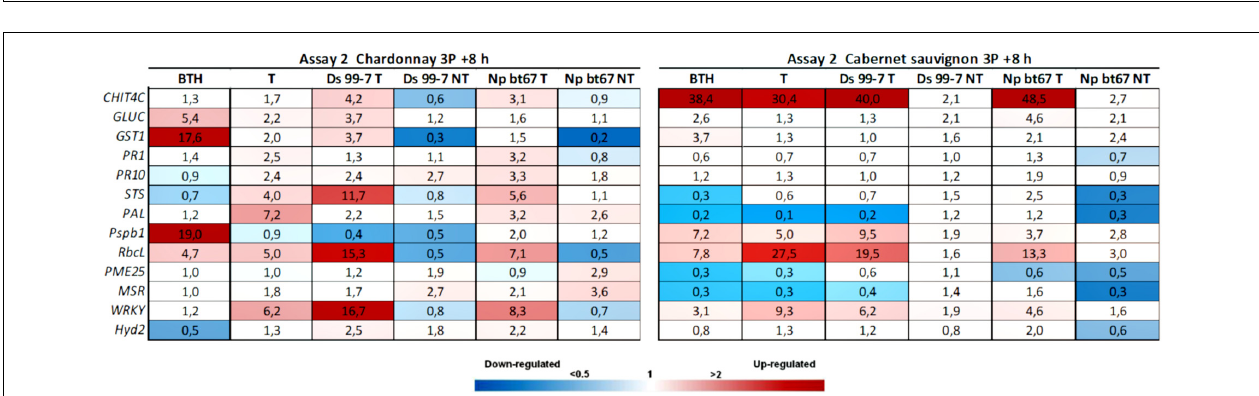
FIGURE 3 | Expression levels of the selected 13 genes recorded by RT-qPCR in “Chardonnay” and “Cabernet sauvignon” 8 h after the second LC2017 treatment (2B) in Assay 2. Values (mean of three technical replicates) represent the expression levels ( (cid:49)(cid:49) Ct) of reported conditions relatively to the control (NT). Expression of a given gene was considered up- or down-regulated when value of relative expression was > 2-fold or < 0.5-fold compared to the control, respectively.